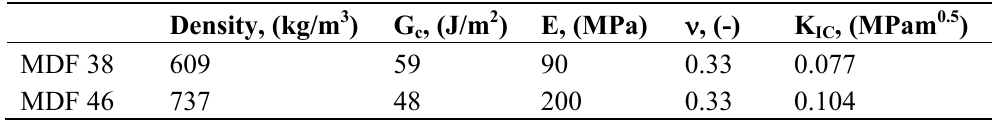
Table 2. Initiation toughness, modulus of elasticity and Poisson’s ratio from [32]; K calculated according to Equation